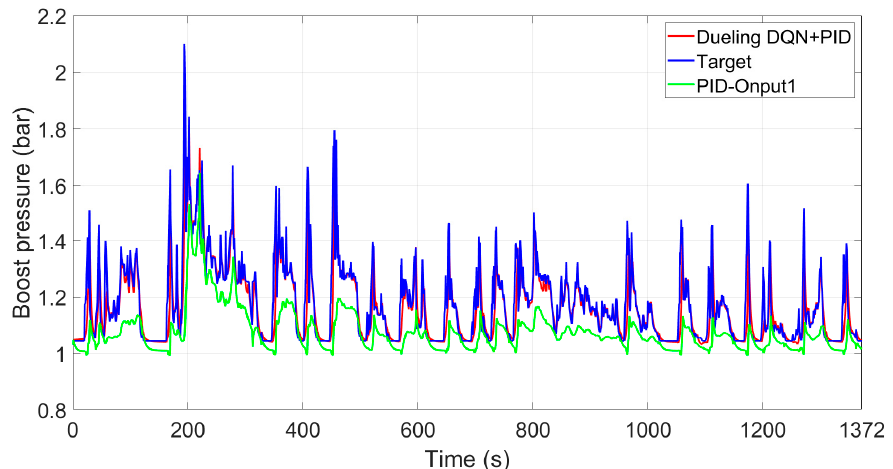
Figure 15. Control behavior between the original PID controller and the hybrid controller when the PID controller